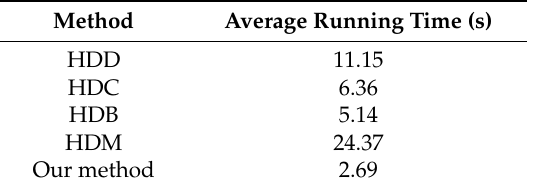
Table 5. Average time (s) of four competing methods and our method.